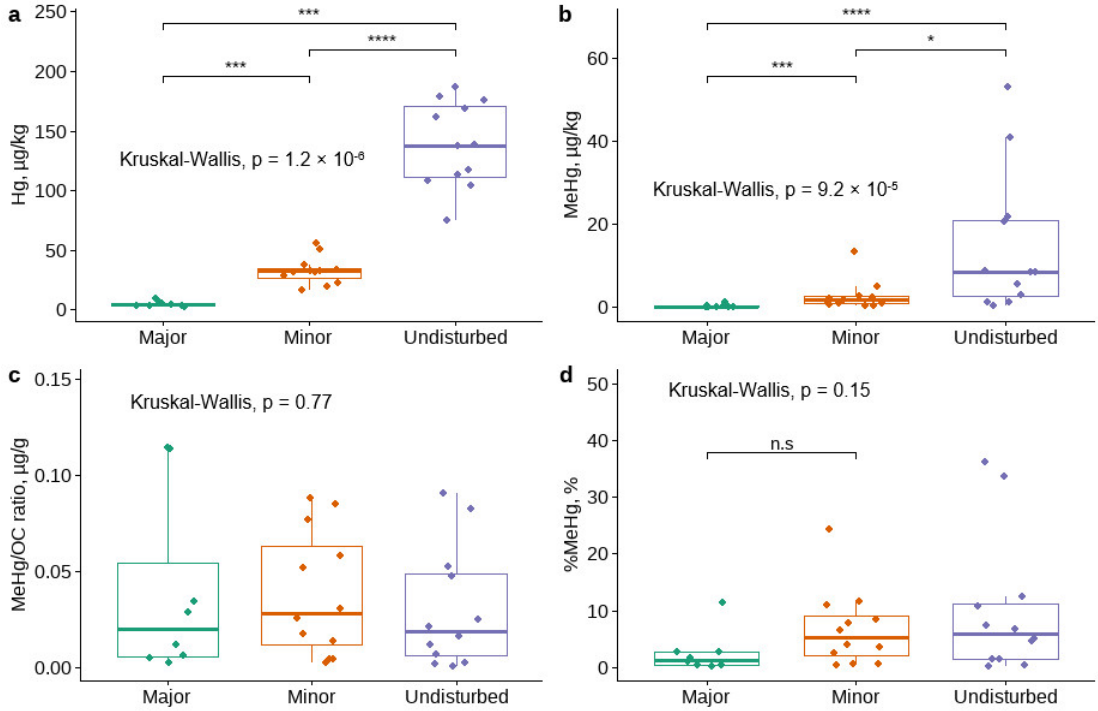
Figure 2. Variations in ( a ) MeHg and ( b ) THg concentrations, ( c ) MeHg/OC ratios, and ( d ) %MeHg in sediments as a function of the level of management-induced disturbance in watercourses. Asterisks above the bar plots indicate the statistically significant differences between the levels of disturbance according to Kruskal-Wallis test (not significant (n.s): p > 0.05; *: p ≤ 0.05; ***: p ≤ 0.001; ****: p ≤ 0.0001).